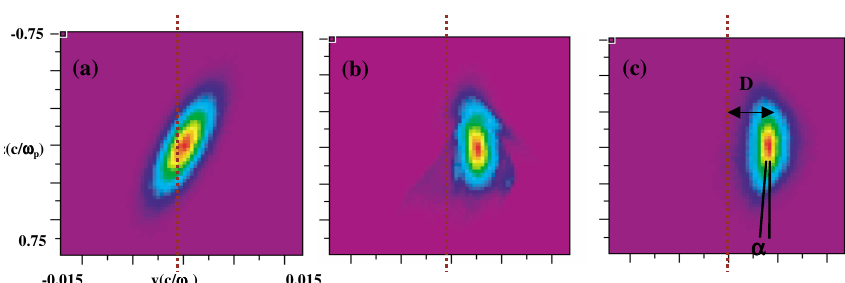
FIG. 7. (Color) Three snapshots of beam evolution over CERN-SPS. (a) At t (cid:2) 0 ; (b) at t (cid:2) 136 s (6 turns); (c) at t (cid:2) 0 : 8 ms for all the snapshots is 1.67 (35 turns). c=! p